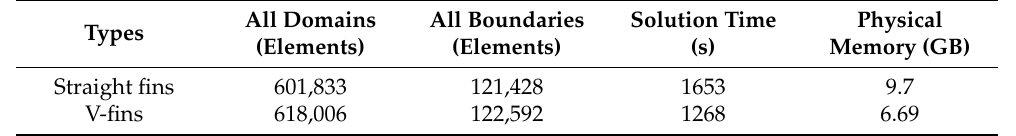
Table 4. The solution time and the physical